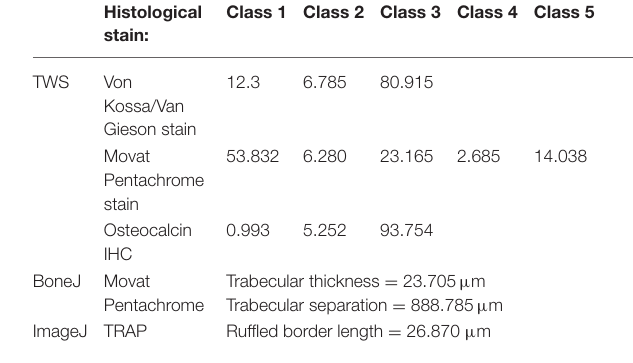
TABLE 1 | Overview of classes defined in different histological stains. Histological stain